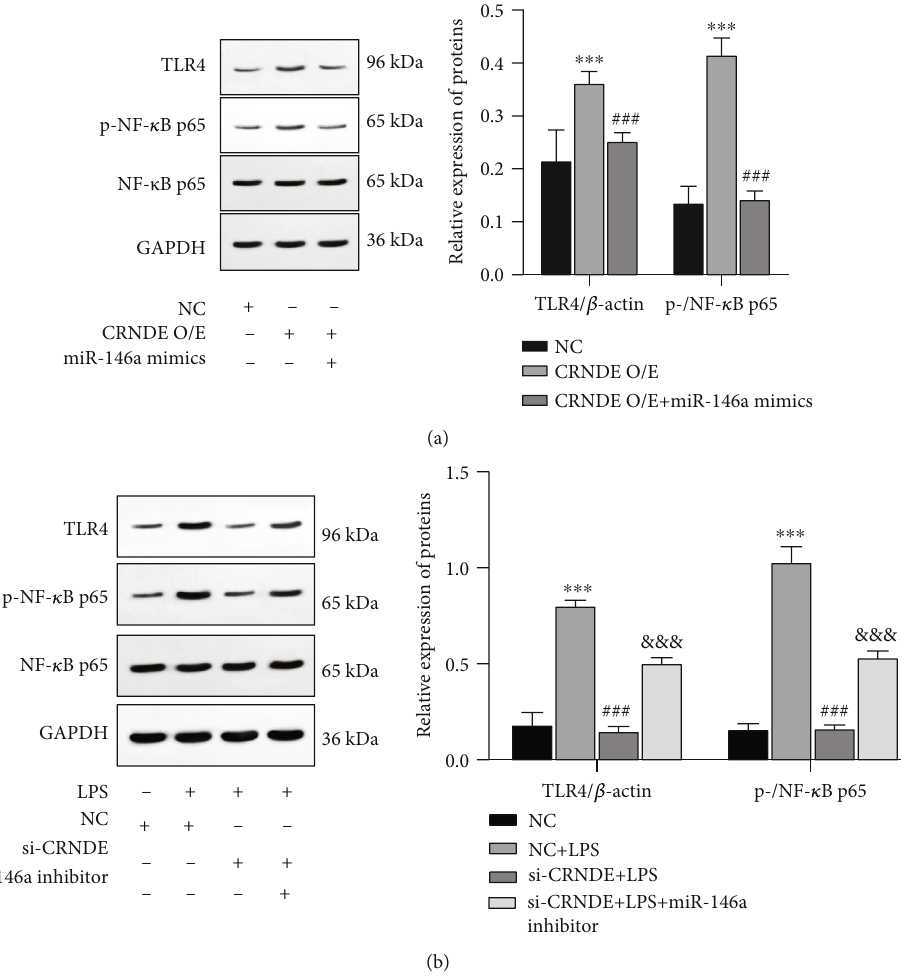
Figure 5: CRNDE induced the activation of the TLR4/NF- κ B pathway by mir-146a. Compared with the control group, ∗∗∗ p < 0 : 001 . Compared with NC+LPS, ### p < 0 : 001 . Compared with si-CRNDE+LPS, &&& p < 0 : 001